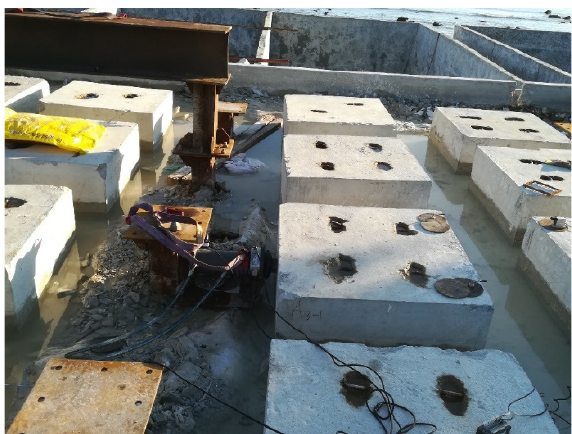
Figure 12. Hg specimen loaded by horizontal jack.